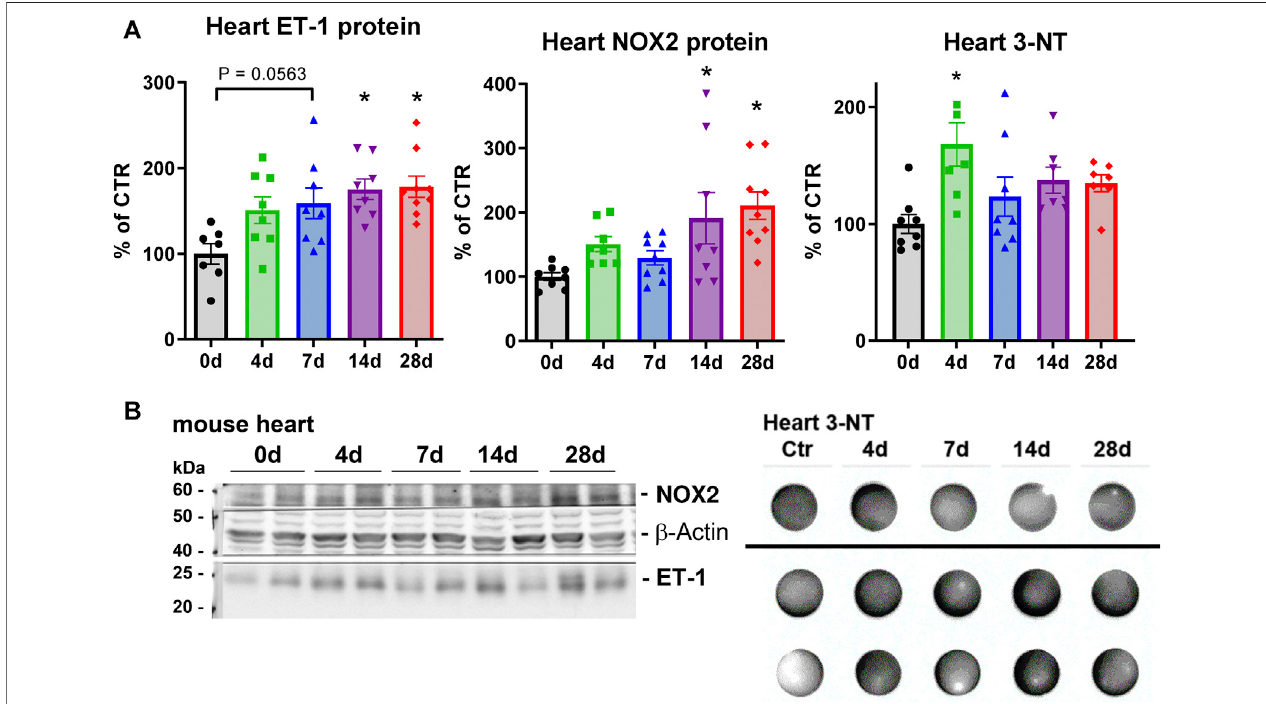
FIGURE 5 | Effects of long-term noise exposure on heart immunoblotting for endothelin-1, NOX2 and 3-NT. (A) Cardiac ET-1 and NOX-2 protein expression by Western blotting as well as levels of 3-NT-positive proteins by dot blotting. (B) Representative original blotting images for the densitometric quanti fi cations. Data points are pooled heart samples, representing 2 animals per point. Statistical analysis with one-way ANOVA with Tukey ’ s multiple comparison test. p < 0.05: * vs respective to 0d.